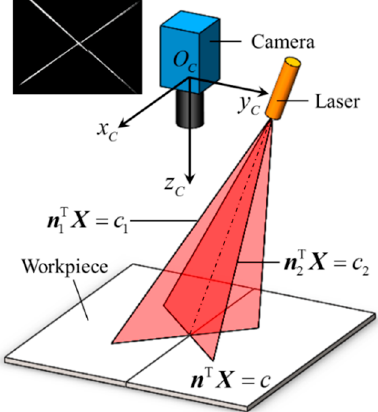
Figure 12. The principle of the double-line laser method.